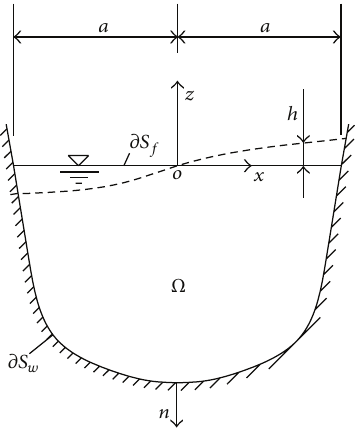
Figure 1: An arbitrary-section